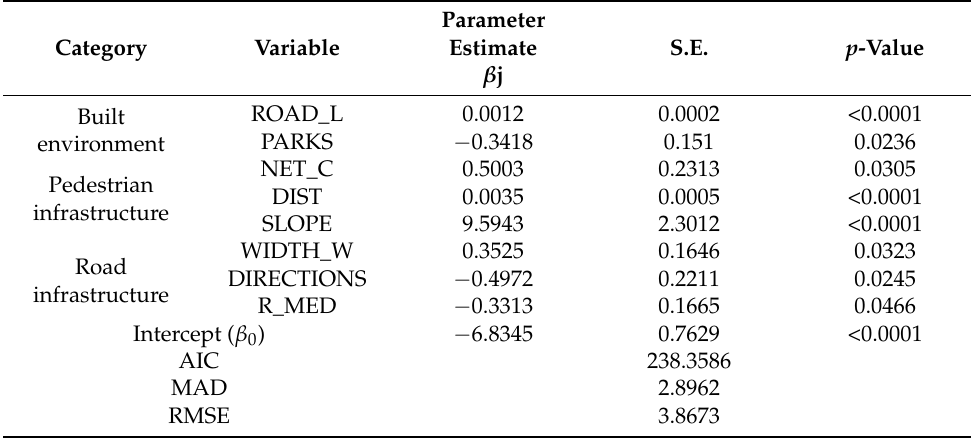
Table 3. ZTNB model—aggregated crash data (Model